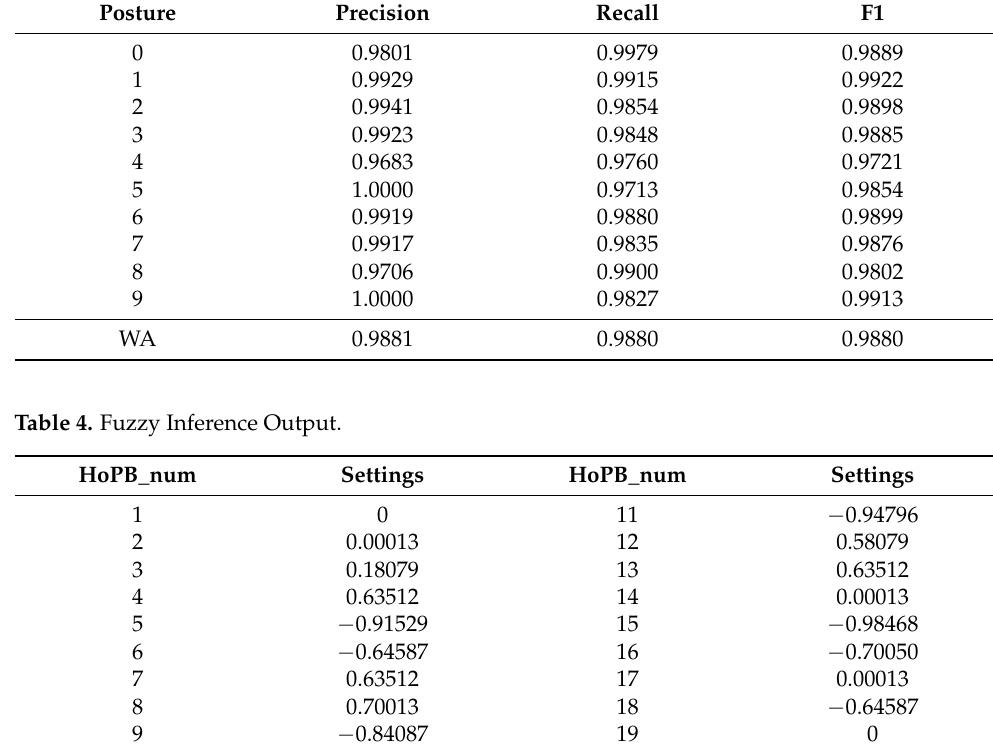
Table 4. Fuzzy Inference Output.